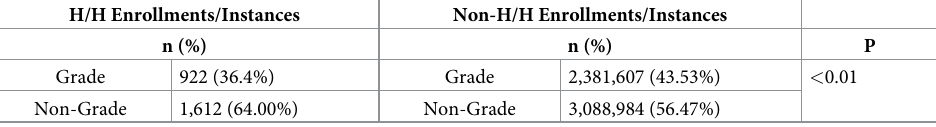
Table 5. H/H vs. non-H/H designated outcomes by course instance (grade generation vs. non-grade